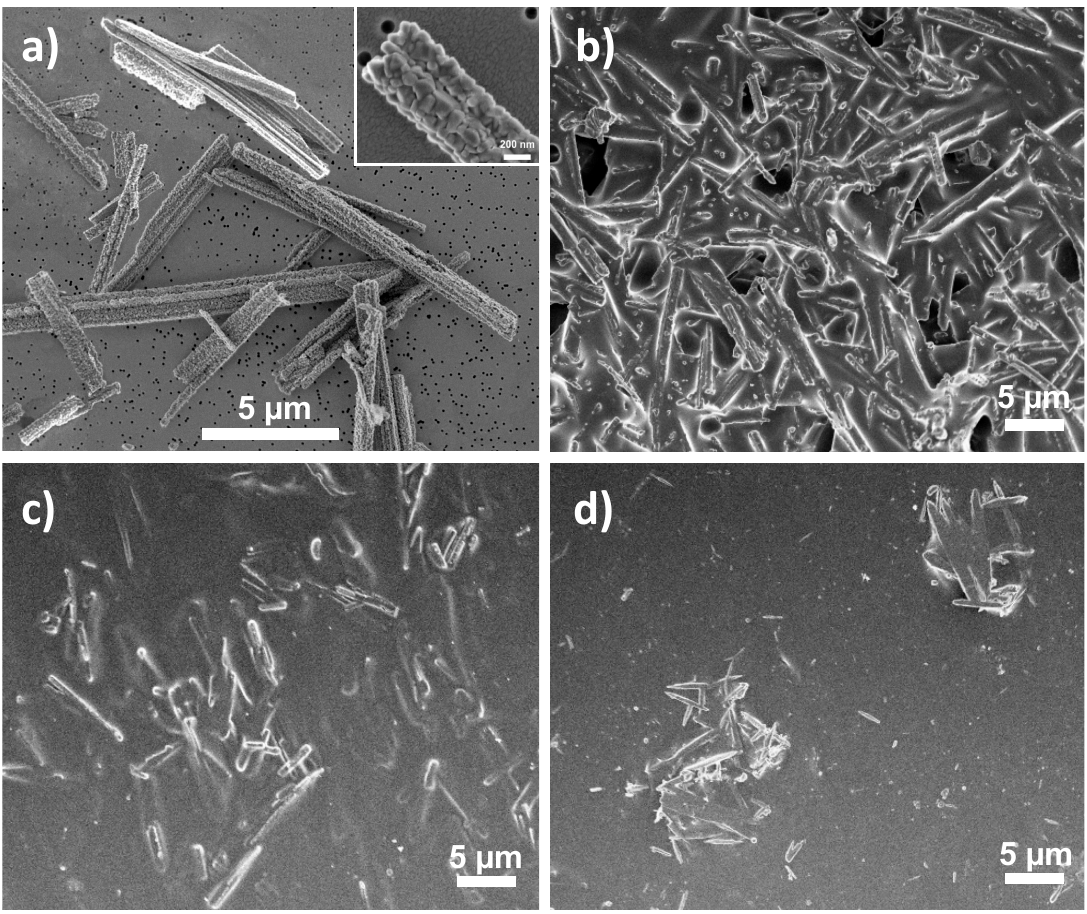
Figure 1. Morphology of ( a ) nanotextured MgO MRs and different MgO/polymer composites with 25 wt % MgO content under SEM: ( b ) MgO/PLGA, ( c ) MgO/PLA, ( d ) MgO/PCL.